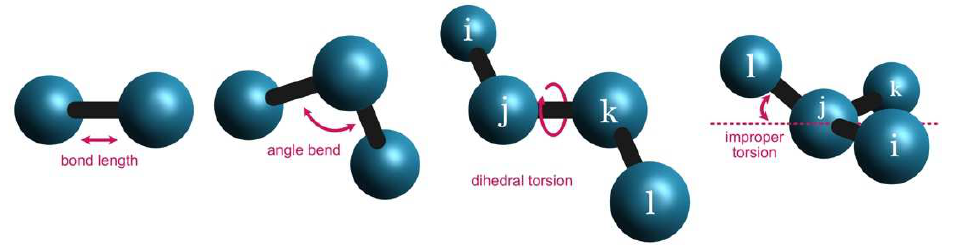
Figure 1. MM bonded terms applied by the AMBER [14] force field.